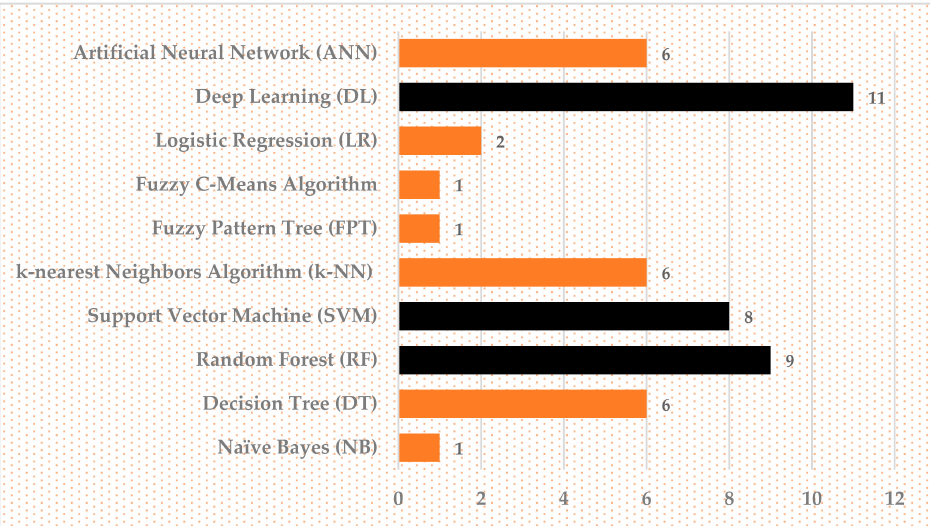
Figure 6. Characteristics of studies based on AI